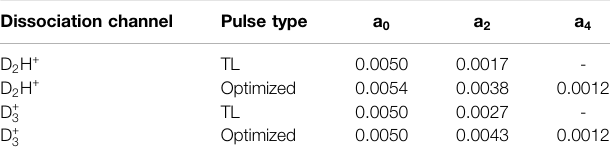
TABLE 2 | Legendre polynomial coef fi cients, a n , obtained by fi tting the probability of dissociation of D 2 H + and D + 3 as a function of cos θ . Dissociation